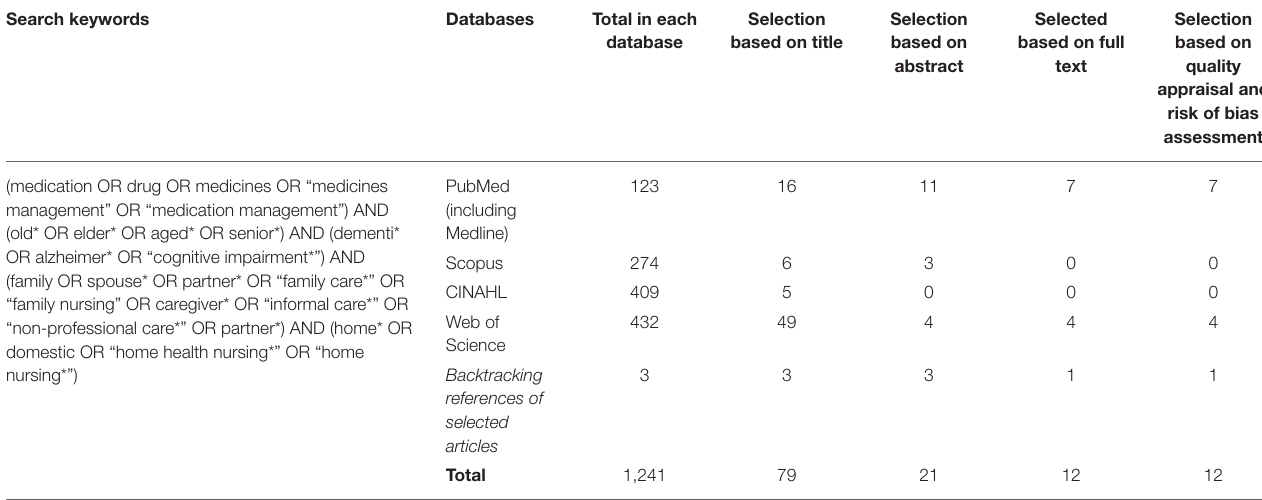
TABLE 1 | The result of search and article selection